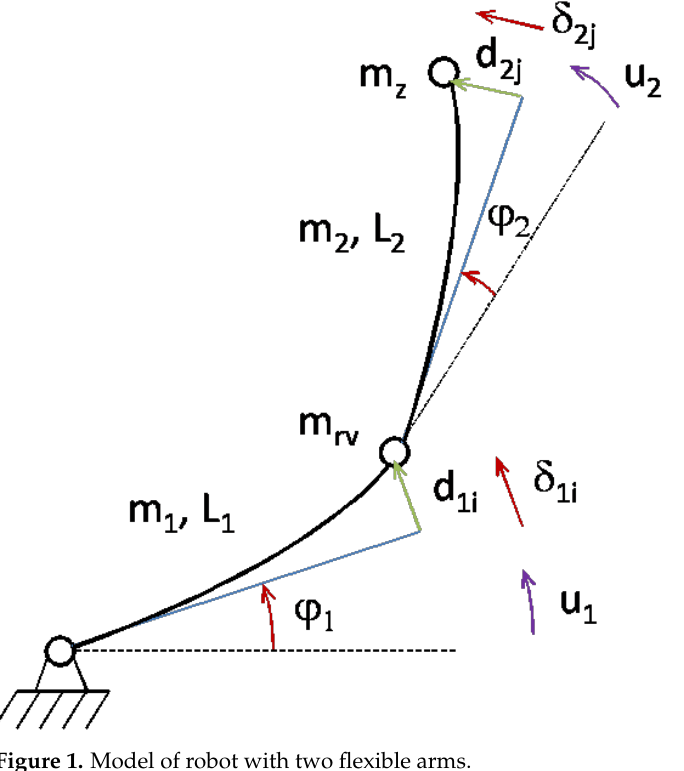
Figure 1. Model of robot with two flexible